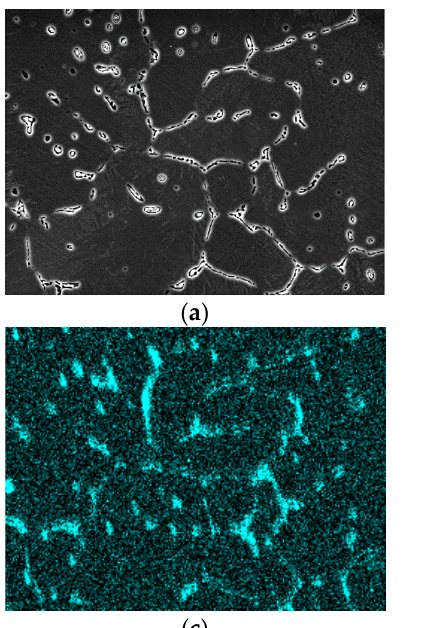
Figure 9. Structure of the Mg ‐ 1Zn ‐ 0.2Ca alloy after HPT+HT at 300 °C: ( a ) SEM; ( b ) transmission electron microscopy (TEM); ( c ) dark ‐ field image of the Ca 2 Mg 6 Zn 3 particle of a globular shape with the corresponding diffraction pattern.